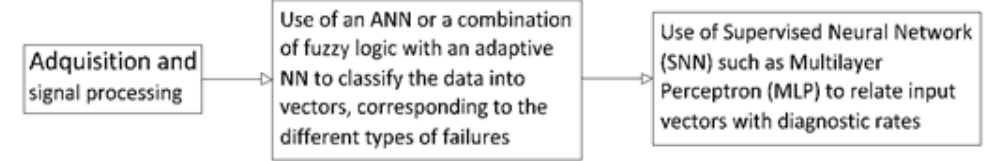
Figure 13. Stages of the monitoring, detection and diagnosis process using Soft Computing (SC) techniques, as shown in [23].